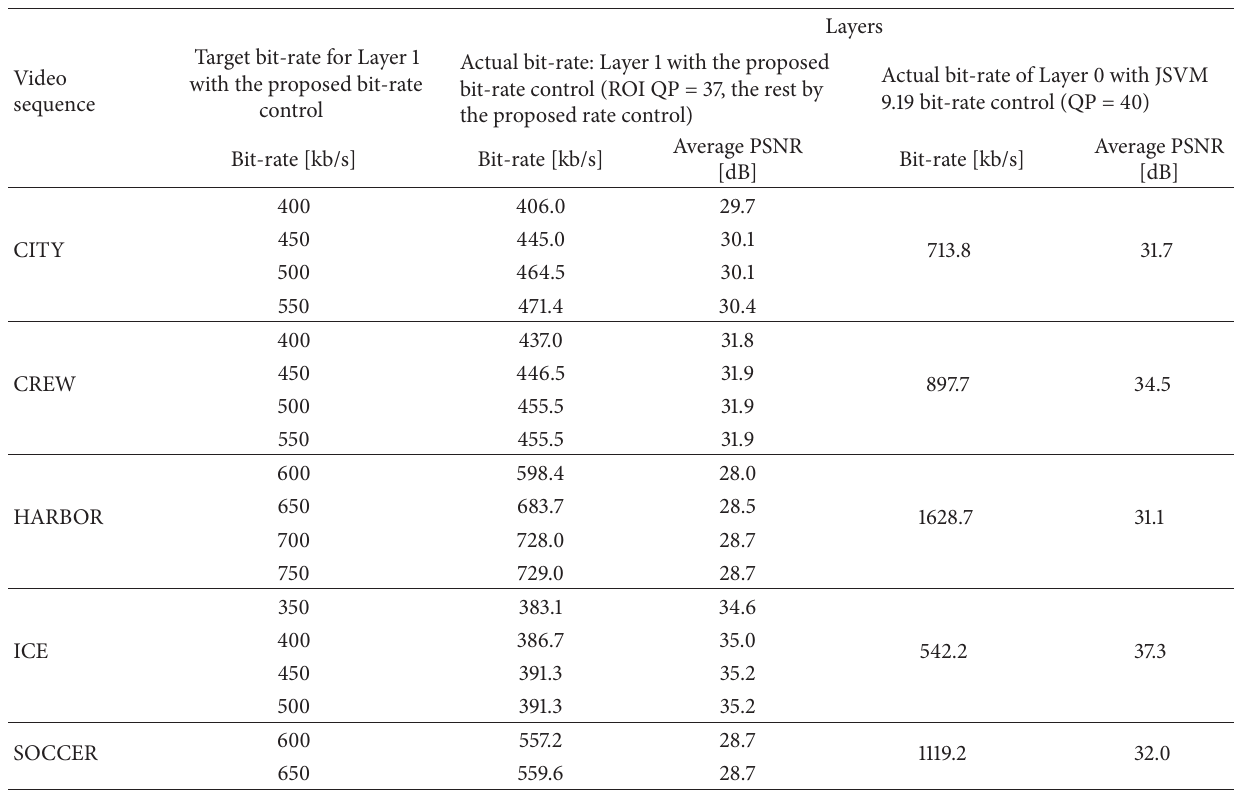
Table 8: Bit-rate control experimental results for “CITY,” “CREW,” “HARBOR,” “ICE,” and “SOCCER” video sequences (ROI QP in Layer 1 is equal to 37; the rest is determined by the proposed bit-rate control scheme; the detailed test conditions are provided in Table 7).